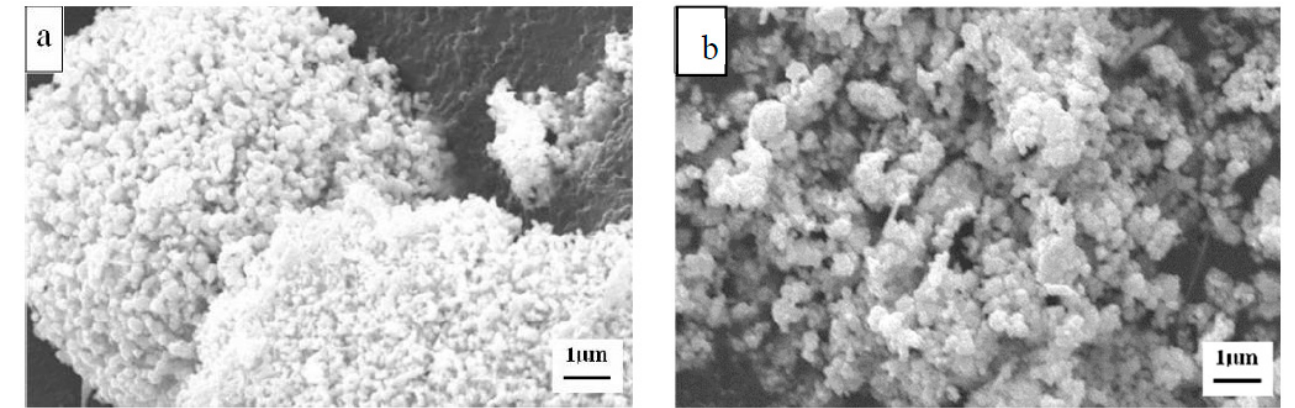
Figure 1. SEM images of the as-received powder ( a ), and the ball milled powder ( b ).